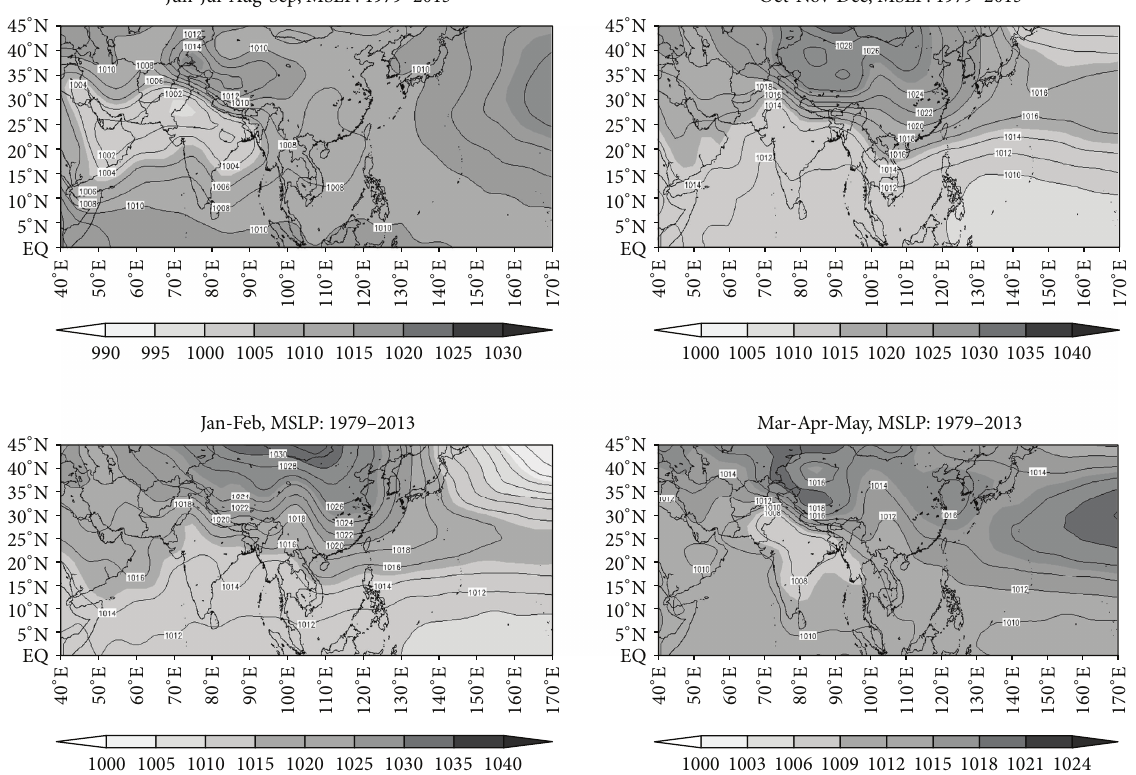
Figure 3: Seasonal climatology of monthly